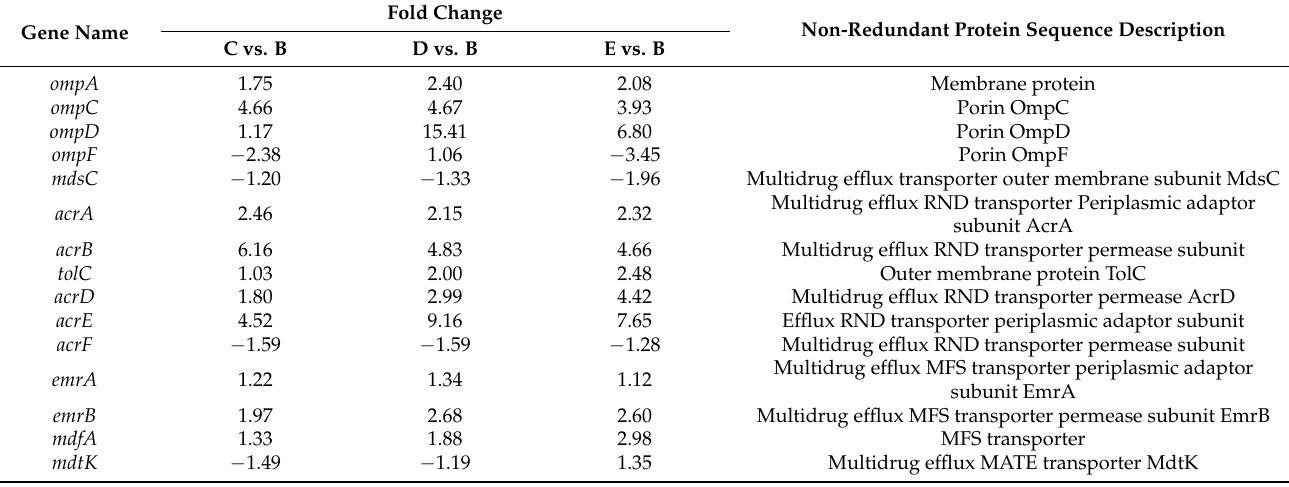
Table 4. Expression levels of MDR efflux pump and OMPs in the transcriptome of S. Enteritidis